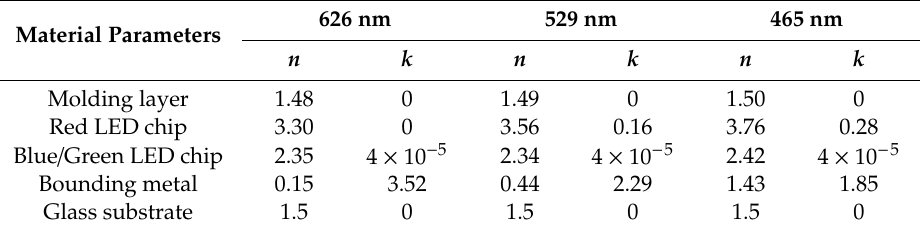
Table 1. Material parameters used in RGB micro-LED display simulations.